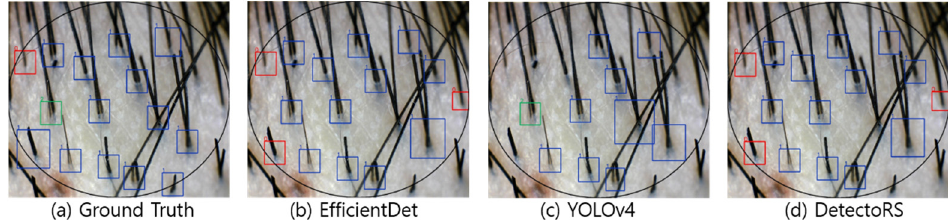
Figure 4. Visualization of detection results in a short hair image. Figure 5. Visualization of detection results in a long hair image. Figure 5. Visualization of detection results in a long hair